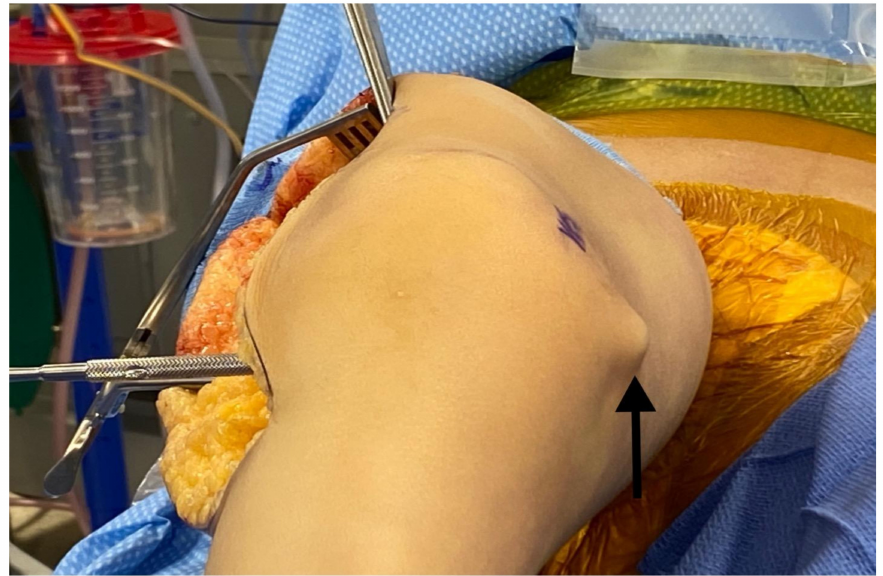
Figure 5. Freer elevator from lateral side demonstrating location of medial incision.